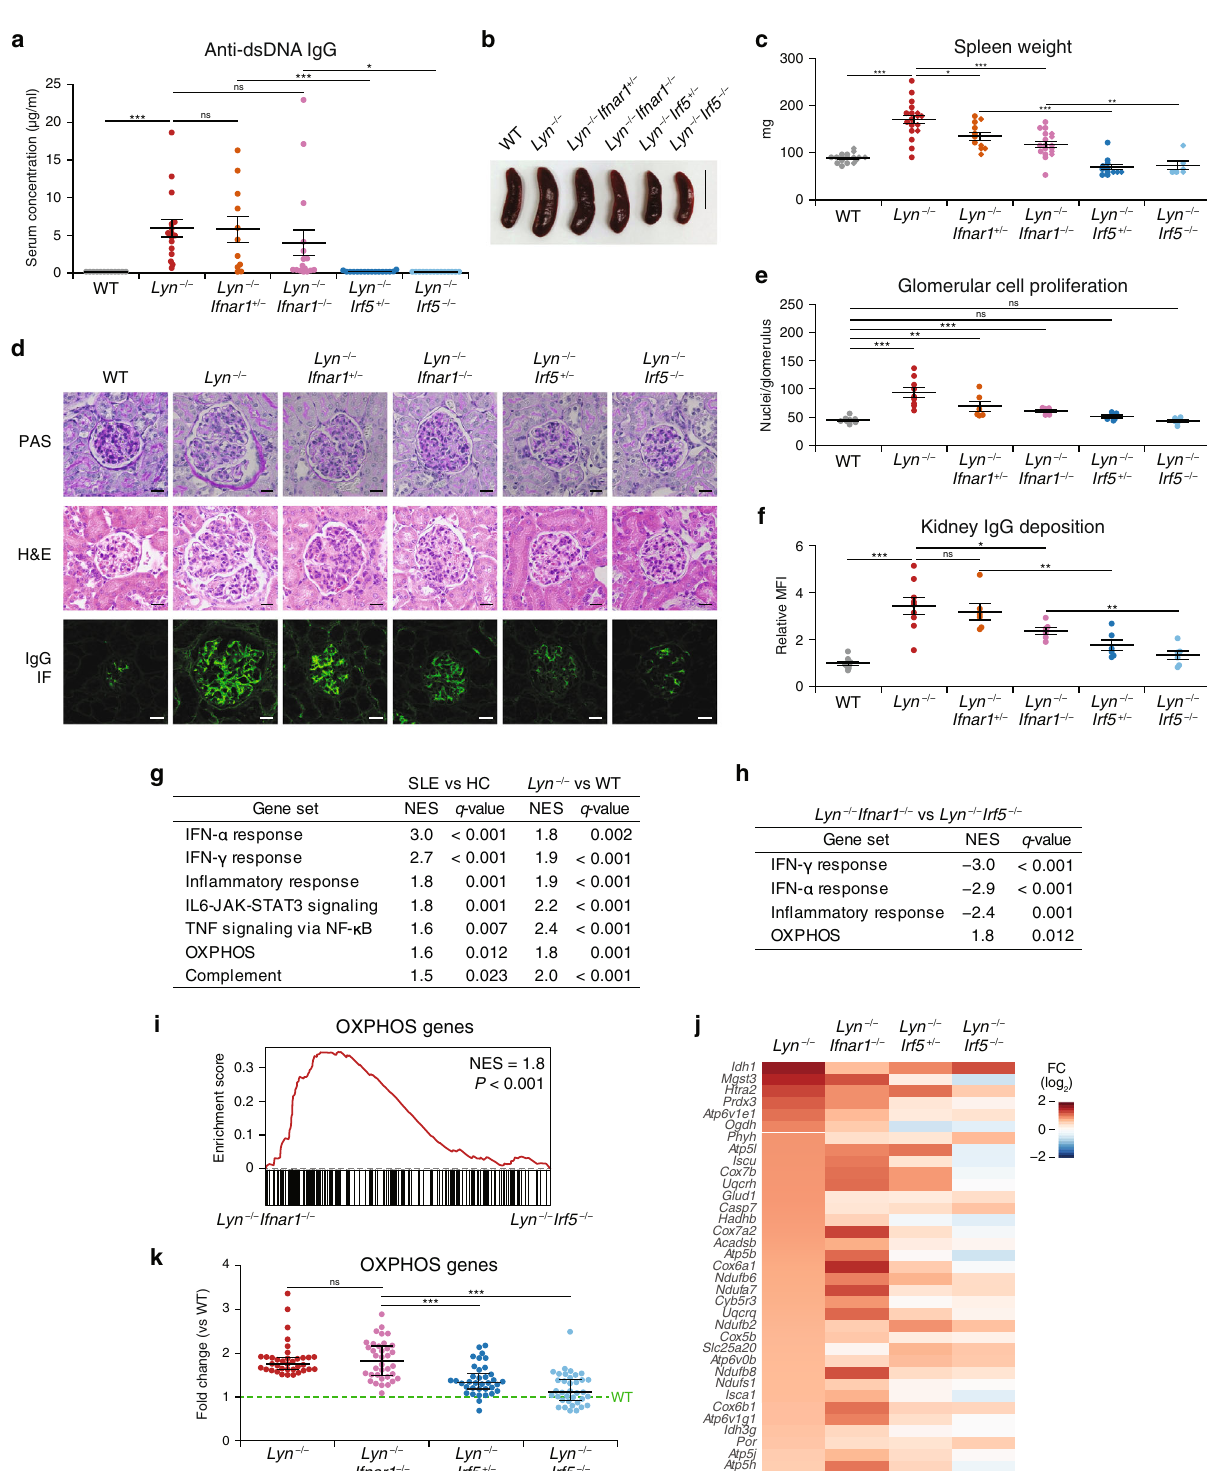
hand, the autoantibody formation was not suppressed either by monoallelic or biallelic deletion of Ifnar1 ( Lyn − / − Ifnar1 + / − or Lyn − / − Ifnar1 − / − ; Fig. 2a). Splenomegaly, glomerulonephritis, and IgG deposits were also much more signi fi cantly weaker in the Lyn − / − Irf5 + / − strain and Lyn − / − Irf5 − / − strain compared to strains Lyn − / − Ifnar1 + / − and Lyn − / − Ifnar1 − / − (Fig. 2b – f). Similar results were obtained for the activation status of innate and adaptive